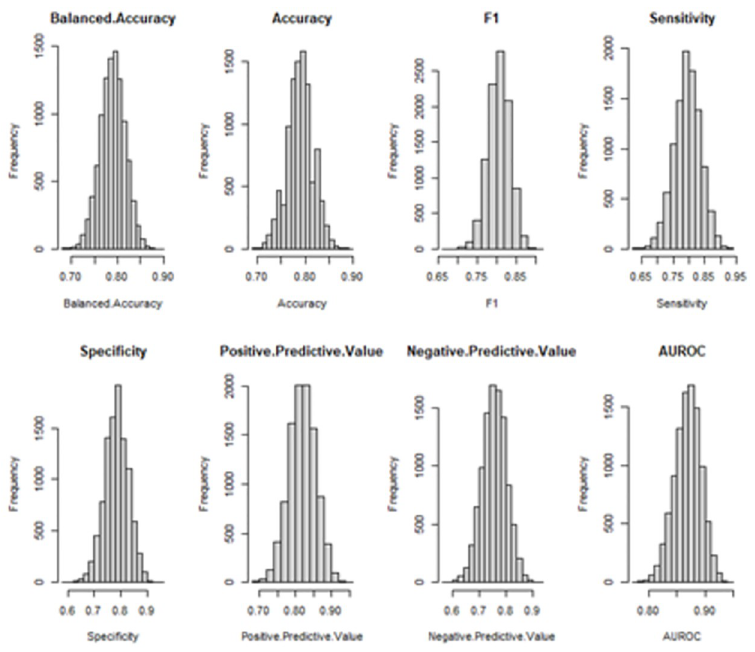
Fig 3. Model statistics summary. Balanced accuarcy, Accuracy, F1, Sensitivty, Specificty, Positive Predictive Value, Negative Predictive Value, Area Under the Receiver Operator Characteristic Curve (AUROC) for the XGboost model following bootstrap simulation.